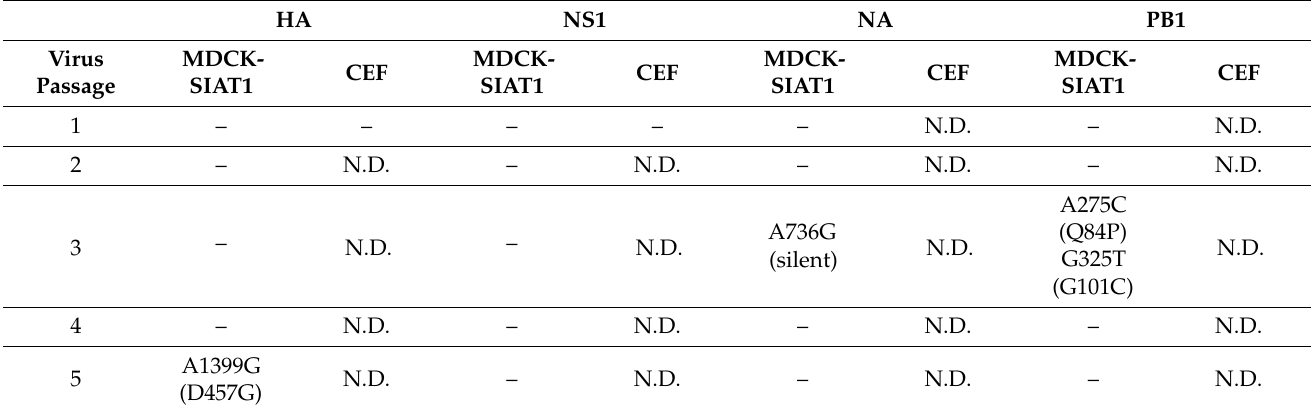
Table 1. Summary of specific mutations in A/Singapore/G2-31/2014 following five serial passages in MDCK-SIAT1 and chick embryo fibroblast (CEF) cells. The dash symbol (–) indicates absence of specific mutations. N.D. denotes the passages in which the full-length gene could not be amplified. HA NS1 NA